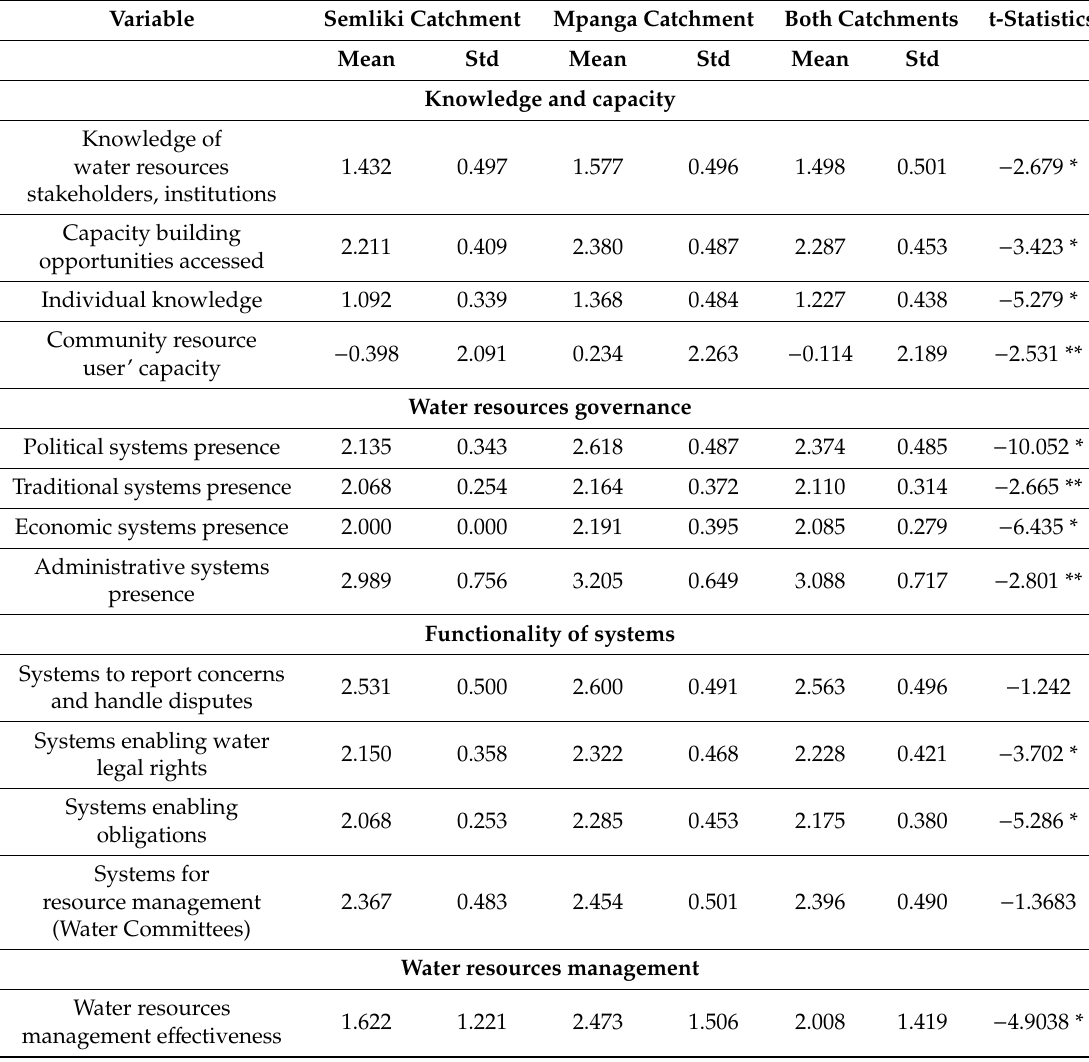
Table 3. Water resources governance characters in Mpanga (n = 156) and Semliki catchments (n =